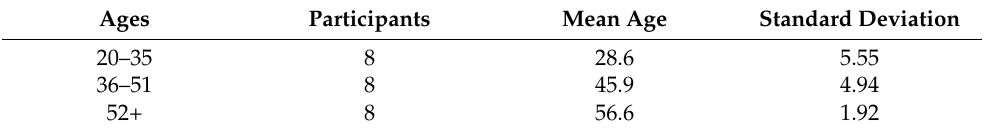
Table 1. Age groups with the number of participants per group, mean age, and standard